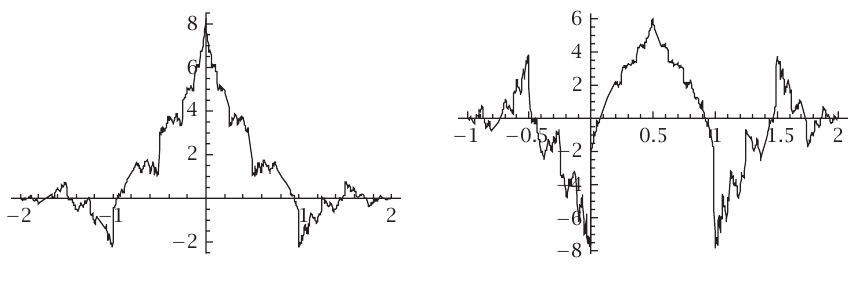
Figure 3.1 . Scaling functions for Example